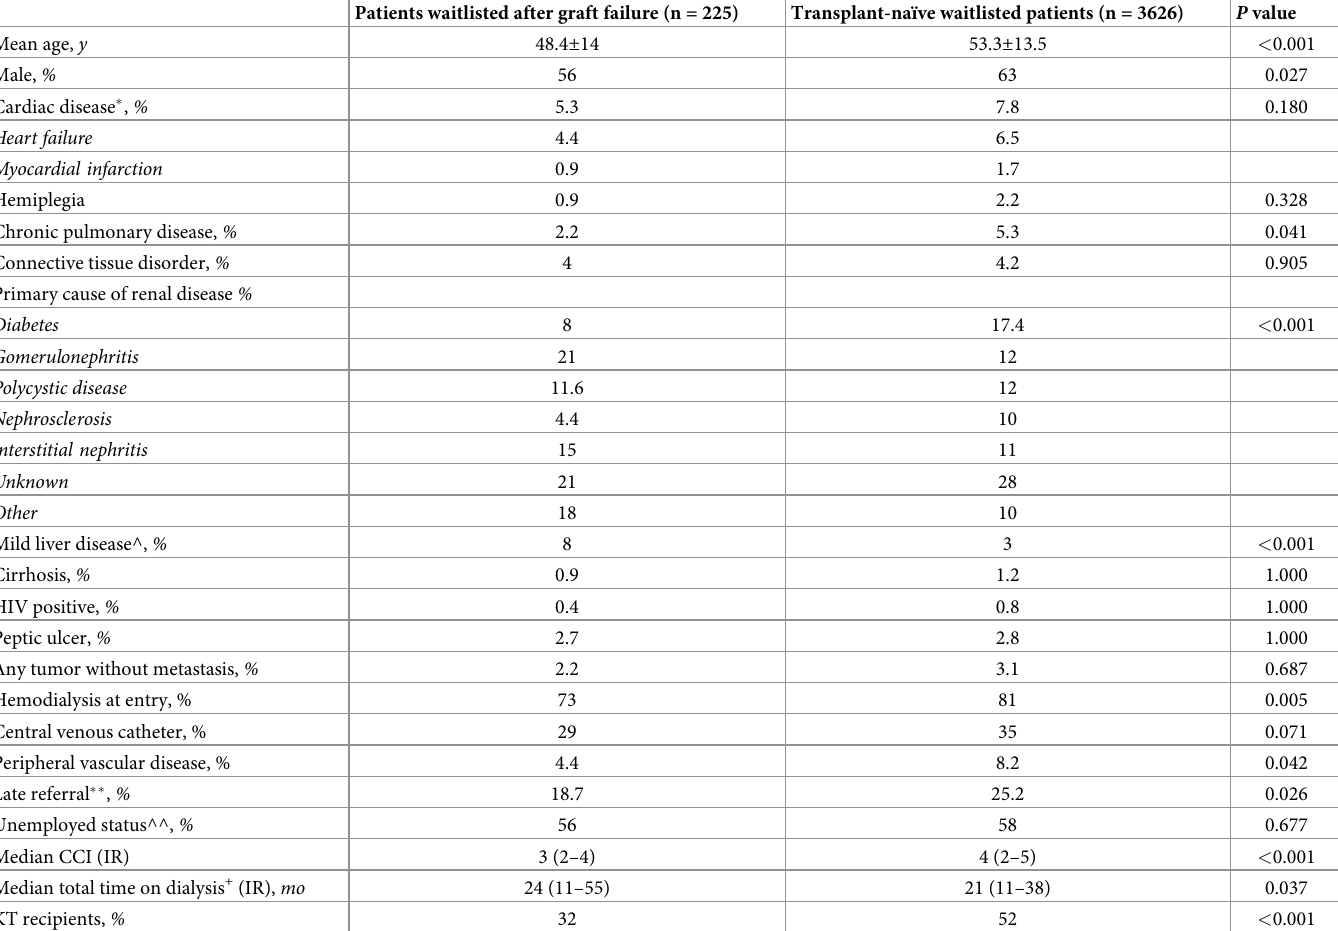
Table 1. Clinical and demographic characteristics of patients waitlisted after allograft failure versus transplant-naïve waitlisted patients. Patients waitlisted after graft failure (n =